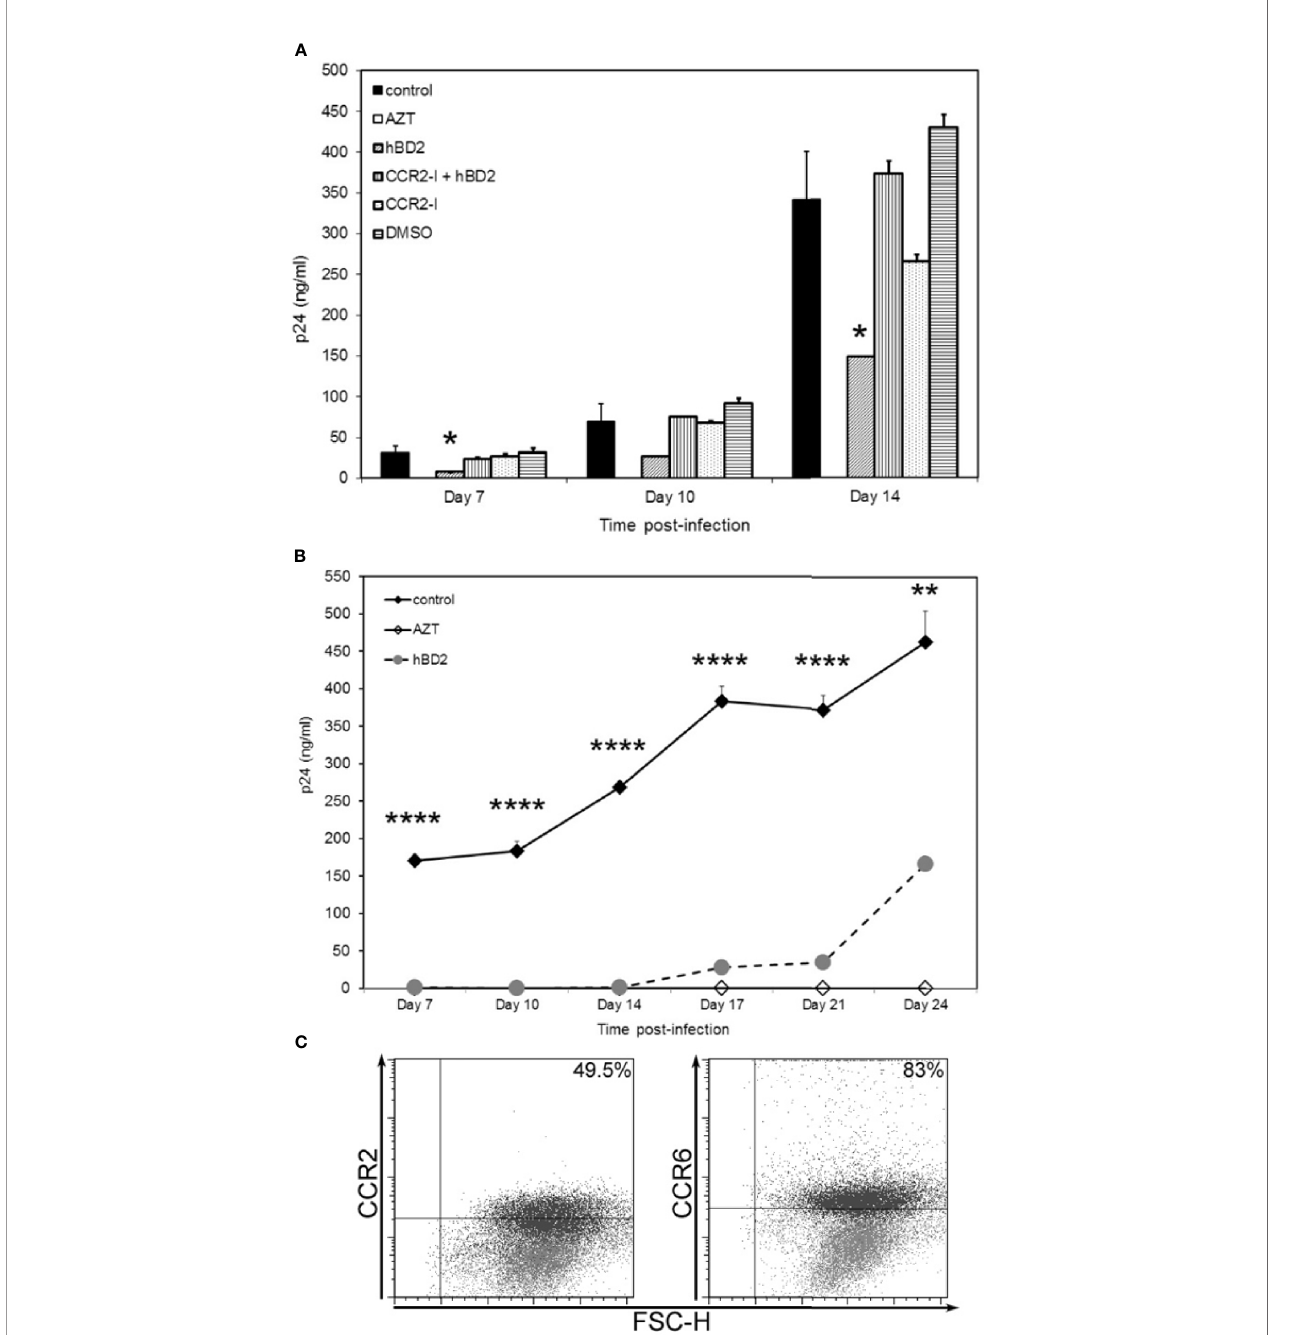
FIGURE 6 | hBD2 can signal via more than one receptor type on macrophages. (A) Neutralization of CCR2 rescues HIV-1 infection. MDM were infected with HIV- 1 BaL . Cells were pretreated with AZT as control. Post-infection, infected untreated cells were pretreated with pharmacological antagonist RS102895 or DMSO control for 2 hrs followed by culture in presence or absence of hBD2 to the cultures. Infection was monitored by assaying supernatants for HIV p24 production by ELISA at the times indicated. Data are presented as mean ± SEM of triplicates. *P < 0.05 between treatment and control infection determined with unpaired two-tailed t test. Representative experiment, n =2. (B) hBD2 signals via an as yet unidenti fi ed receptor. MDM, that were CCR2- CCR6- (by FACS staining), prior to start of infection, were infected with HIV-1 BaL . Cells were pretreated with AZT as control. Post-infection, cells were cultured in presence or absence of hBD2. Infection was monitored by p24 ELISA. Data are presented as mean ± SEM of triplicates. **P < 0.005, ****P < 0.0001 between treatment and control infection determined with unpaired two- tailed t test. (C) CCR2 and CCR6 surface expression levels vary with time. Uninfected, untreated cells from the donor used in (B) were harvested and stained for fl ow cytometry analysis as described in Materials and Methods . Data analyzed using FlowJo software. Forward scatter dot plots show the fl uorescence and percentage of cells positive for CCR2 and CCR6 at Day 0 (grey) and Day 23 (black) as compared to the respective isotype-matched